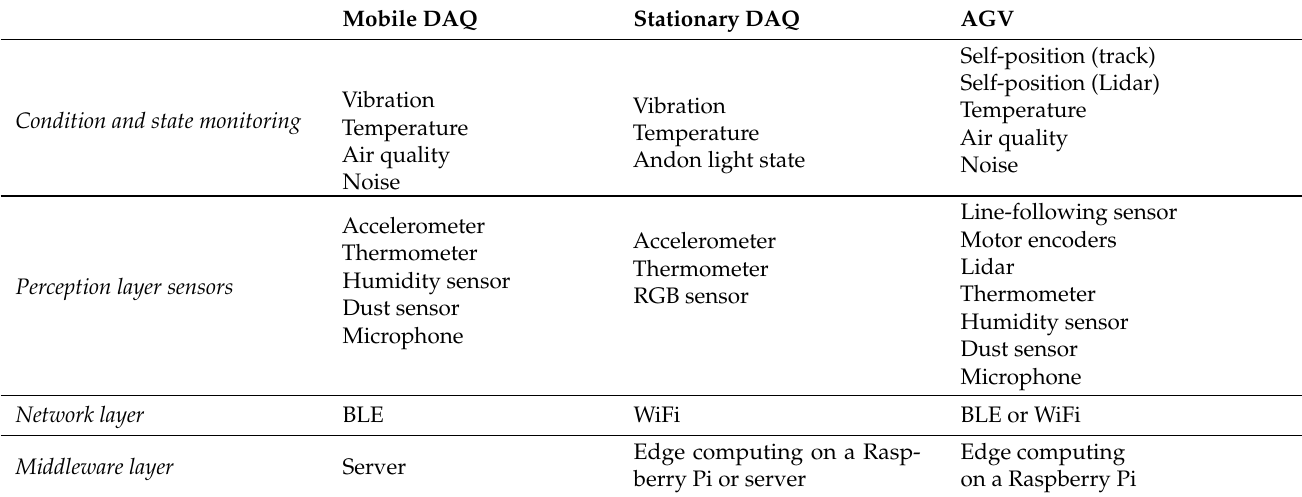
Table 3. Self-developed sensor solutions.